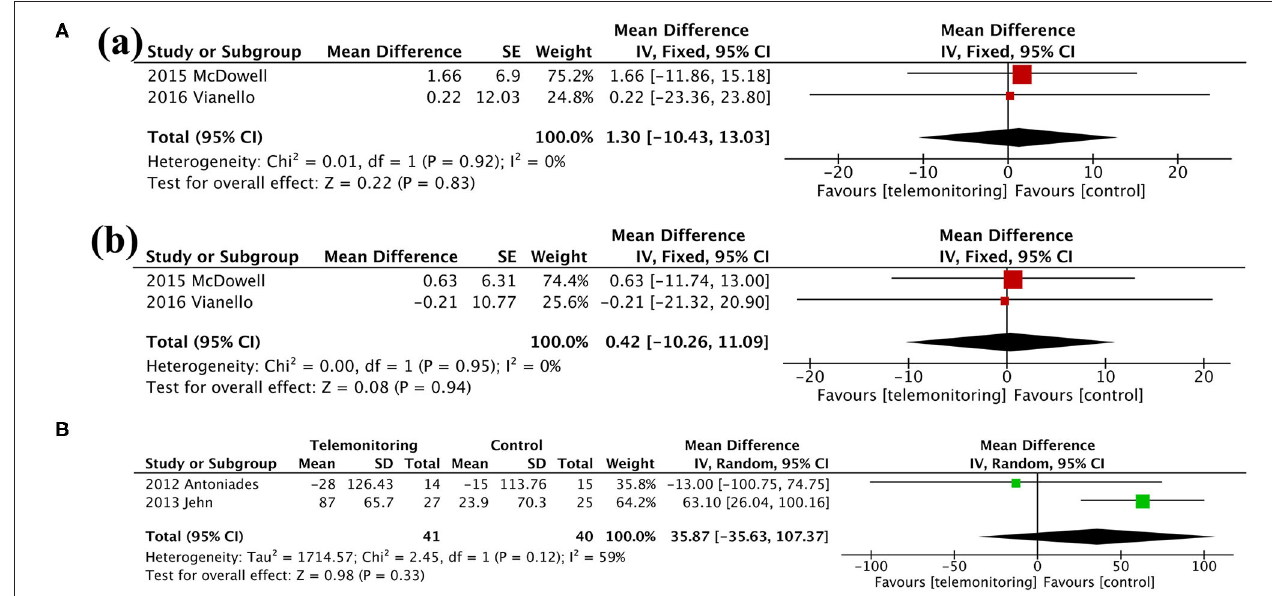
FIGURE 6 | Meta-analysis. (A) Anxiety and Depression: (a) HADS-A and (b) HADS-D. (B) Exercise capacity: 6MWT. HADS-A, Hospital Anxiety and Depression Scale-Anxiety; HADS-D, Hospital Anxiety and Depression Scale-Depression; 6MWT, 6-min walking test.